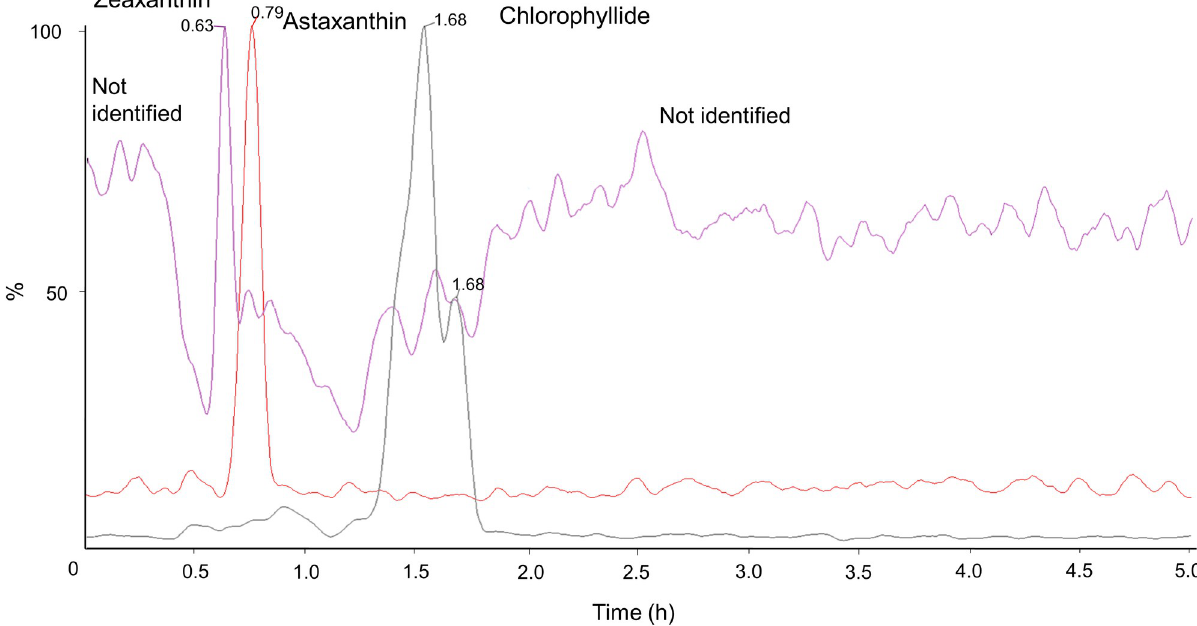
Fig 1. Chromatogram of the Chlorella vulgaris functional alcoholic beverage in ethyl acetate.